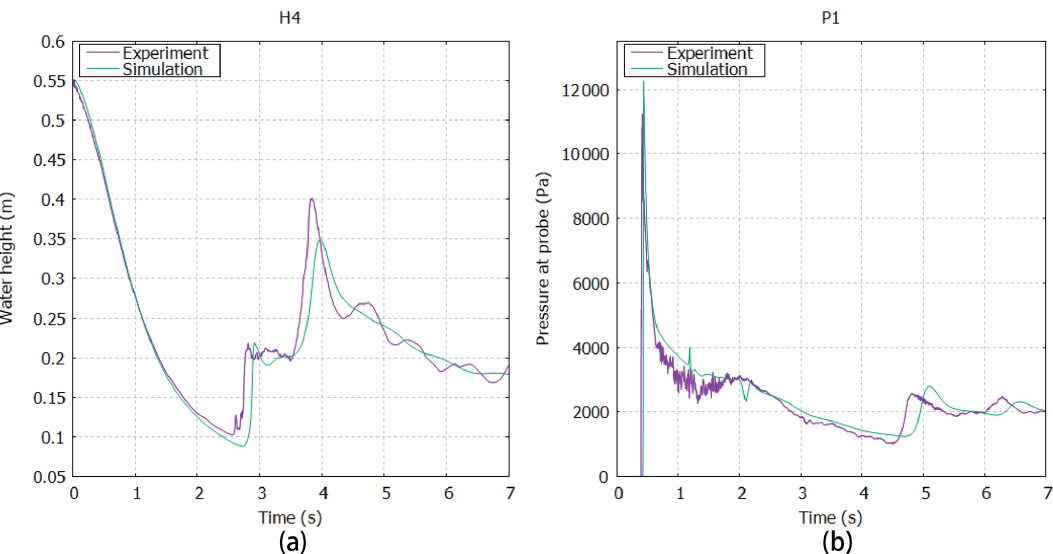
Figure 5. Comparison of vertical water heights in the reservoir at probe H4 (a) and the characteristic curve of pressure changing with time at probe P1 (b) between experimental data and simulation